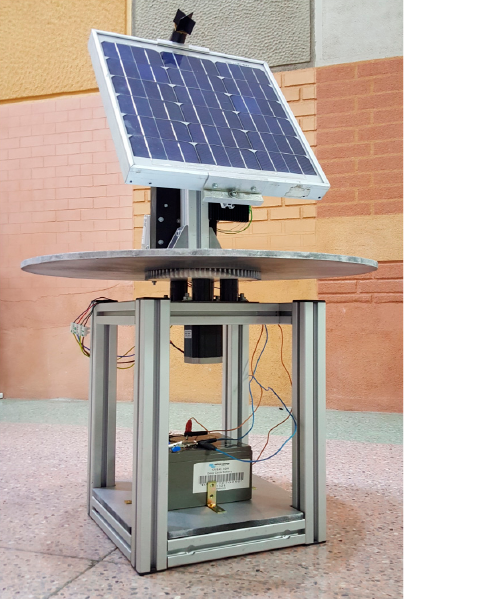
Figure 8. Real scheme of wiring of the prototype’s elements.